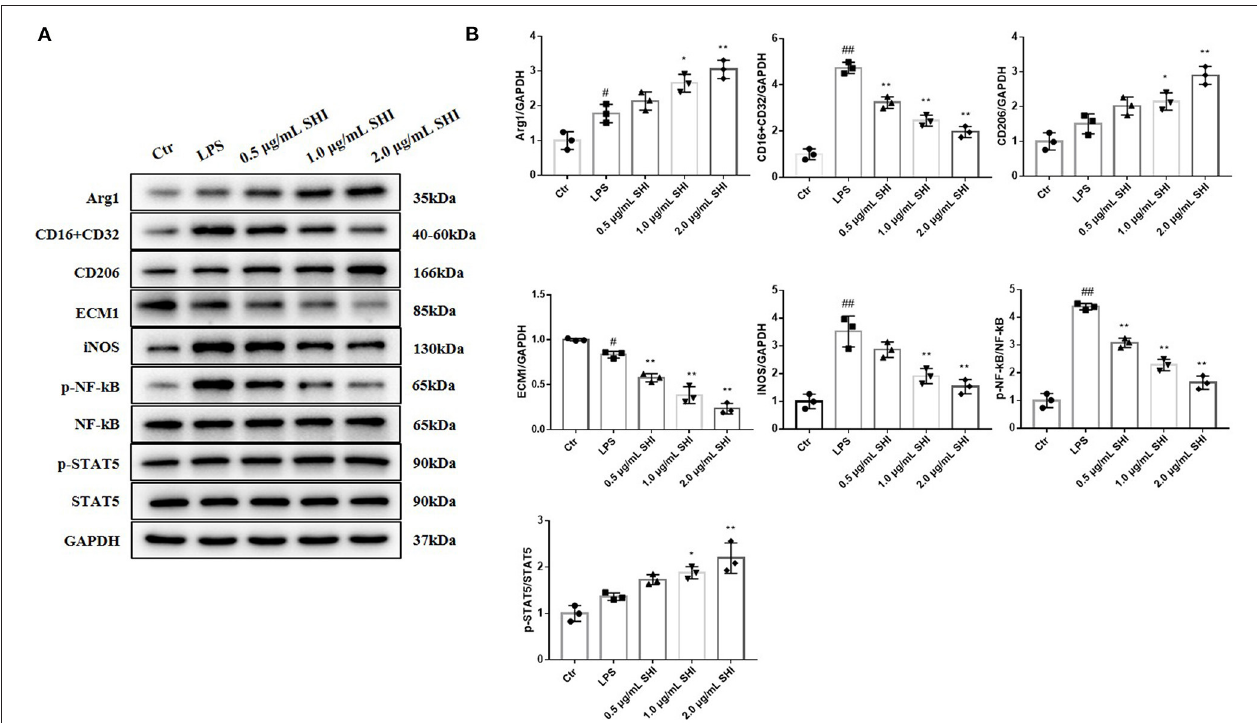
FIGURE 5 | The effects of Shionone on Arg1, CD16 + CD32, CD26, ECM1, iNOS, p-NF- κ B, NF- κ B, p-STAT5, and STAT5 in LPS-treated RAW264.7 cells. (A) Western blot analyses of expressions of Arg1, CD16 + CD32, CD26, ECM1, iNOS, p-NF- κ B, NF- κ B, p-STAT5, and STAT5 in LPS-stimulated RAW264.7 cells with or without Shionone treatment ( n = 3). (B) Histogram of relative expression of each protein ( n = 3). Control group was used as a negative control and LPS group as a positive control. Results are expressed as ± SD for independent experiments, # p < 0.05 vs. Control group, ## p < 0.01 vs. LPS group, and * p < 0.05 vs. Control group, ** p < 0.01 vs. LPS group, one ANOVA followed by Tukey’s post-hoc